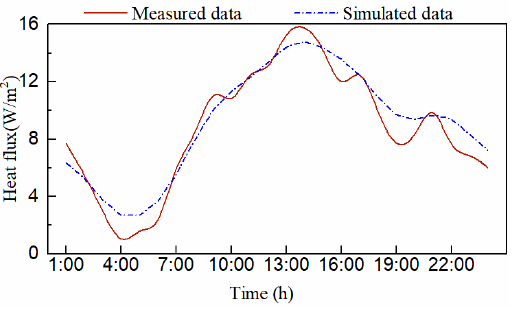
Figure 11. The agreement between the simulation and the monitoring results. The normalized mean bias error (NMBE) and the coefficient of variation (CV) of the root mean square bias error (RMSE) were used to evaluate the consistency of the normal- ized mean bias error (NMBE). The NMBE value indicates the existence of systematic error or deviation, while CV (RMSE) is a powerful indicator of simulation accuracy [47]. NMBE